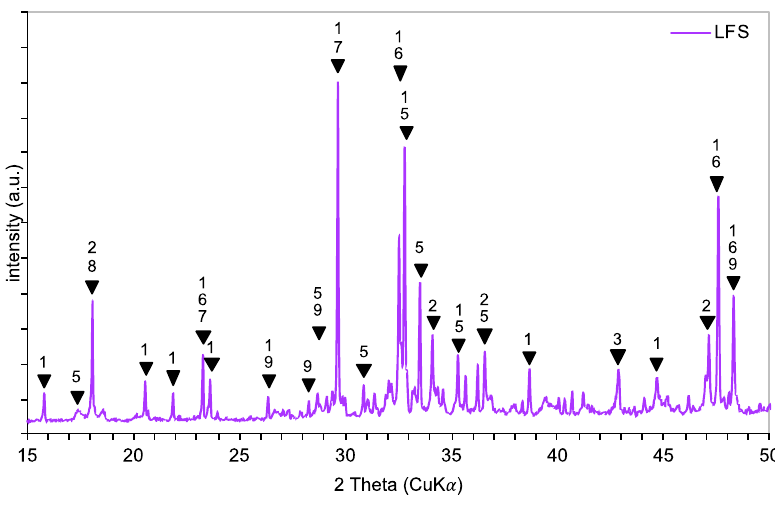
Figure 1. XRD pattern of ladle furnace slag Figure 1 . XRD pattern of ladle furnace slag (LFS).